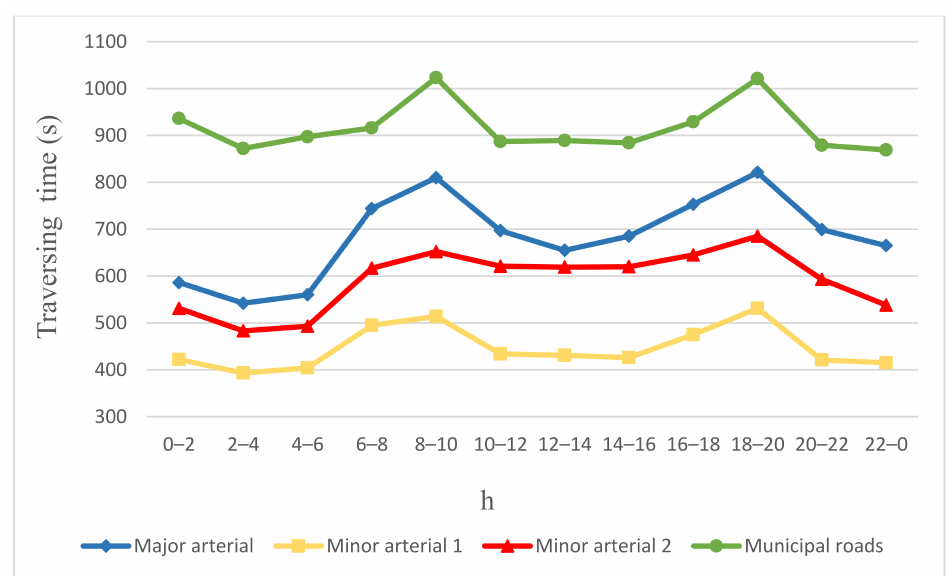
Figure 8. Traversing times of PEVs/SAEVs after applying real time rideshare coordination.